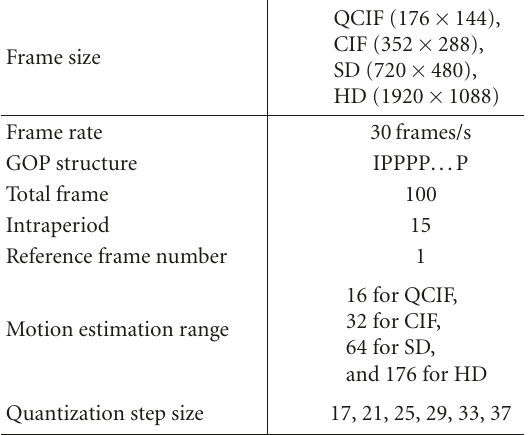
Table 5: Encoder parameters for the experiments.